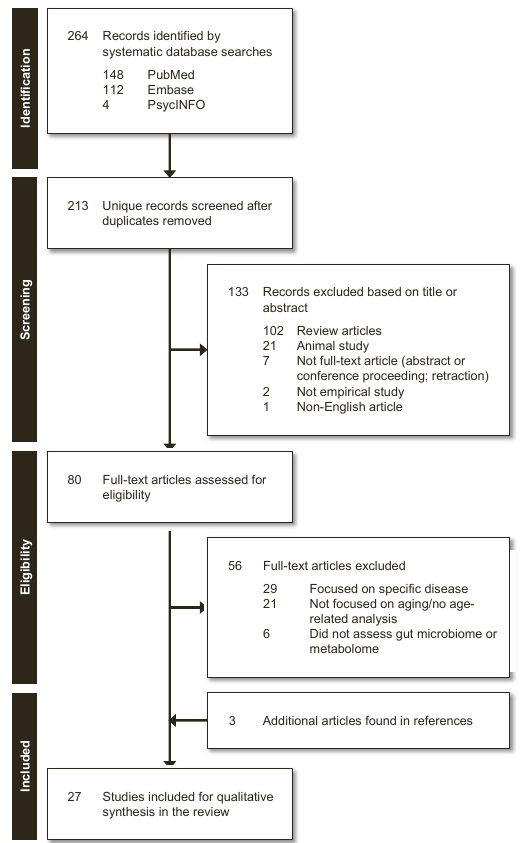
Figure 1. PRISMA-based selection flow chart of reviewed articles.